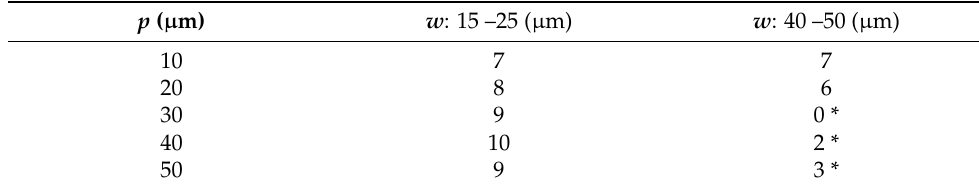
Table 3. Statistical significance in dry perception between samples with  values of 40 and 50 µm. Table 4. Number of trials in which participants perceived that samples with a w value of 25 µ m were rougher than those with a w value of 15 µ m and that those with a w value of 50 µ m were rougher than those with a w value of 40 µ m for various p values. * Significance level <